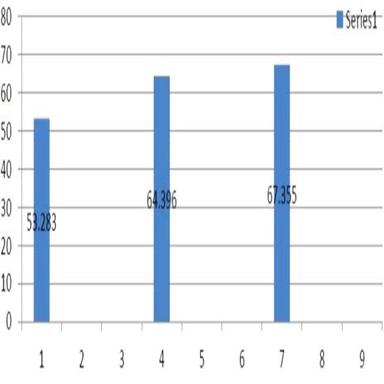
Graph of hardness values of three samples.